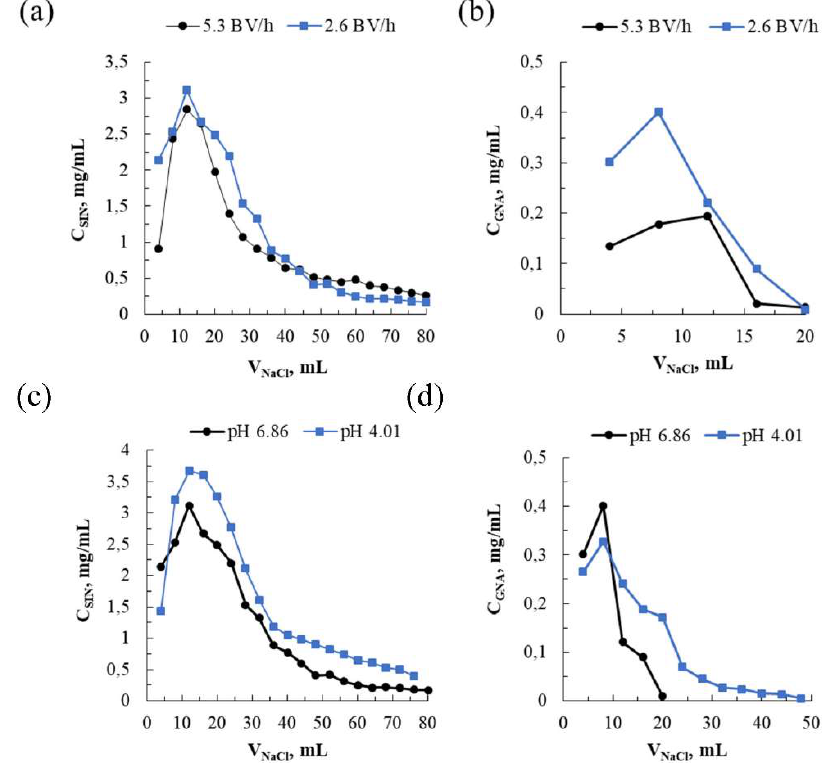
Figure 17. Evolution of sinigrin ( a , c ) and gluconapin ( b , d ) concentration during the desorption process versus the volume of NaCl solution pumped continuously through the column with layer of PA312LOH resin at different flow rates ( a , b ) and pH ( c , d ).